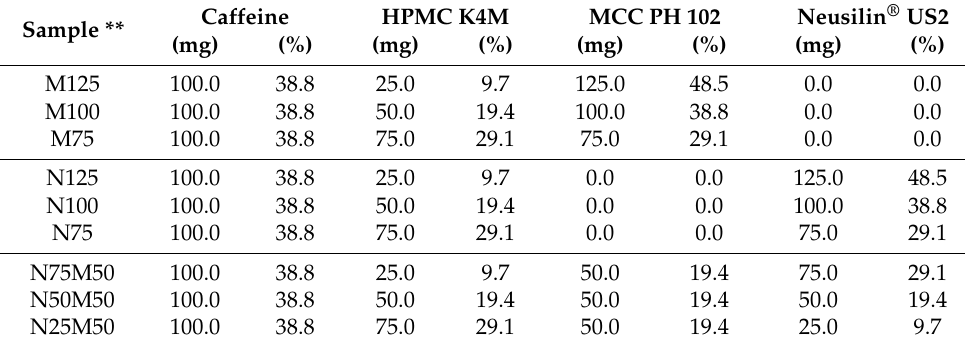
Table 1. Matrix tablets composition